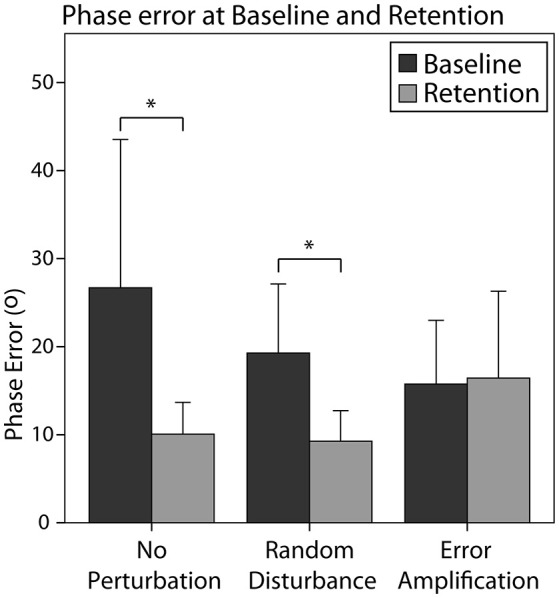
Absolute phase error for the different training groups during baseline and retention. Error bars show ± 1 CI. *p < 0.05.